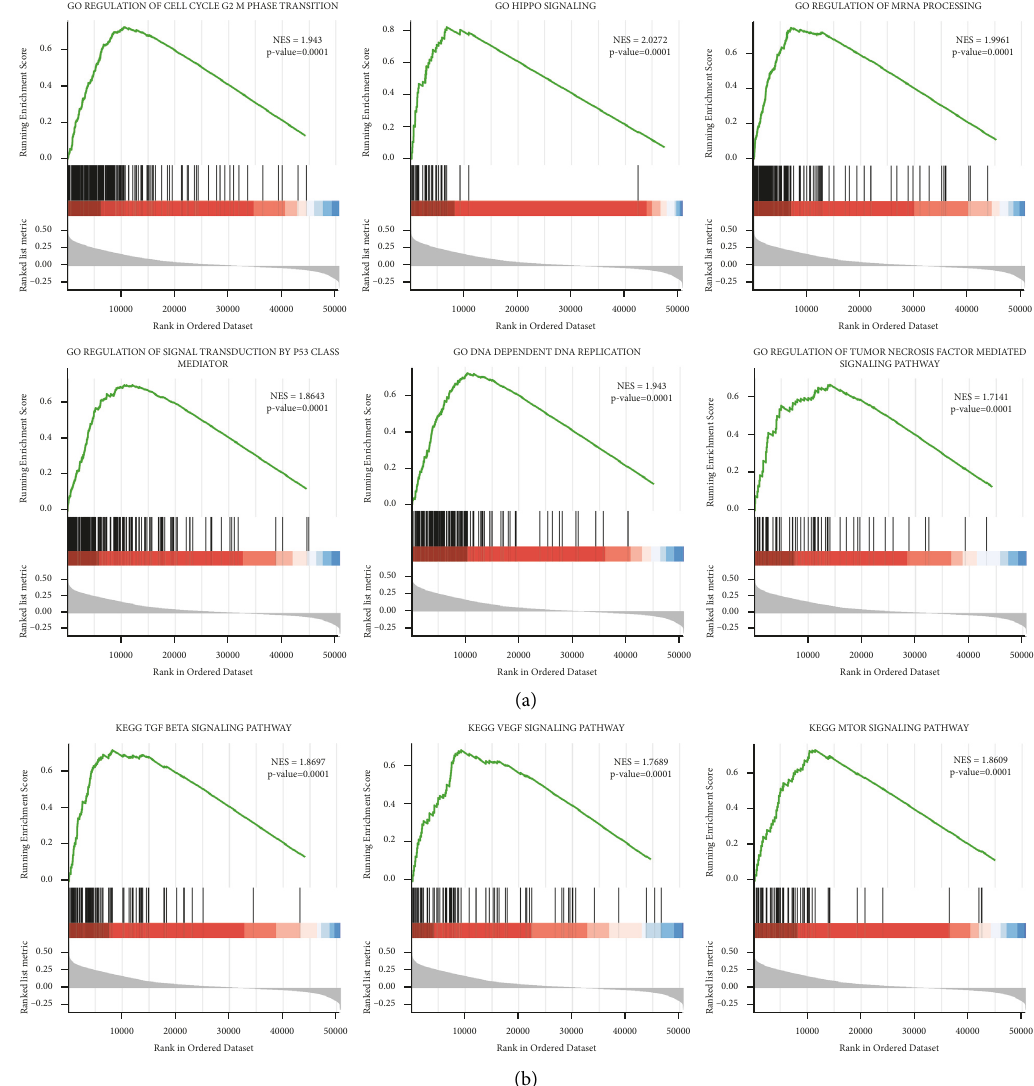
Figure 6: GSEA of the risk score model. (a) GSEA of GO processes. (b) GSEA of KEGG pathways. NES: normalized enrichment